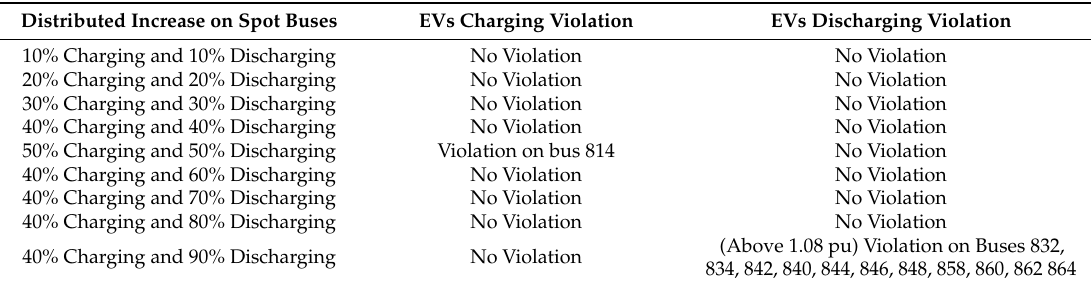
Table 9. Case 4 Maximum Charging/Discharging Load kW during Peak